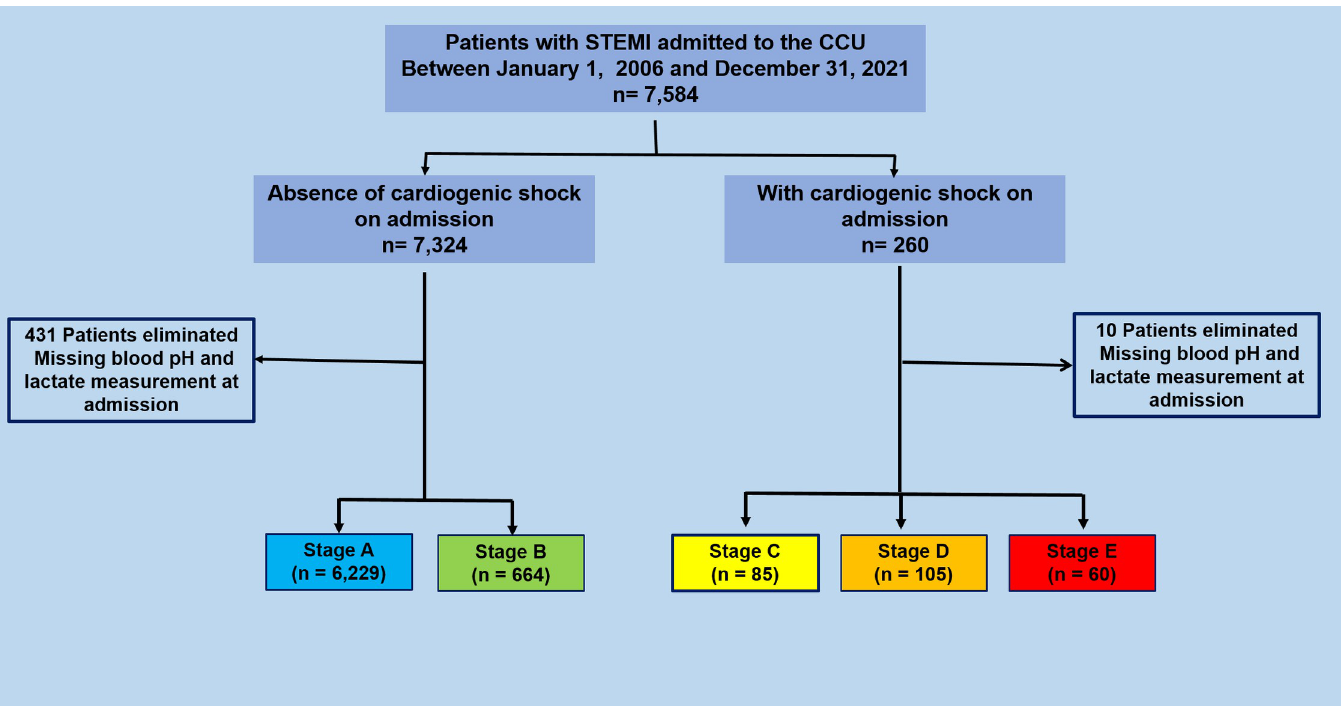
Fig 1. Flow chart illustrating the study sample selection.